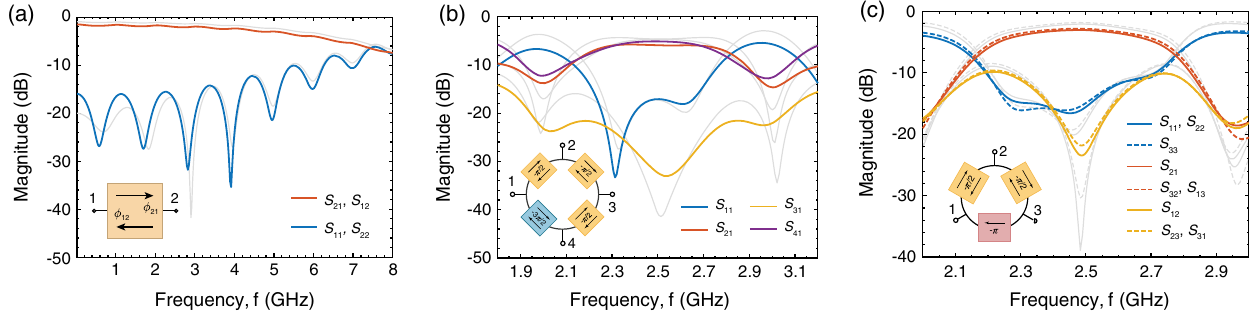
FIG. 10. The effect of realistic nonidealities of switches on the performance of the (a) commutated network, (b) rat-race coupler, and (c) circulator shown in Figs. 1(d) and 8(a), and 9(a), respectively. The on switch resistance is set to be 3 Ω , and the rise and fall times are 10 ps. We also include a random clocking error with a normal distribution of the time over which each switch is closed, with a mean ¼ 42 . 5 ps ( t ¼ T =N − 20 ps with N ¼ 16 paths) and a standard deviation of 3 ps. For comparison, along with realistic equal to t s ON ON scattering parameters plotted in color, we also plot their idealized counterparts as light gray shadow curves [see Figs. 1(e) and 8(b), and